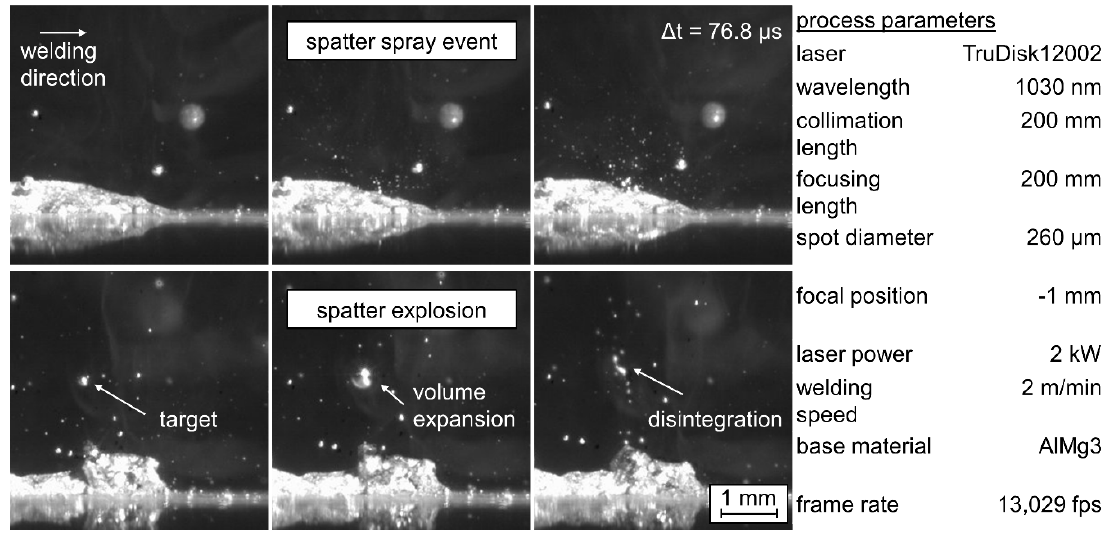
Figure 7. Frame series in the side view of a spray event and spatter explosion for AlMg3.